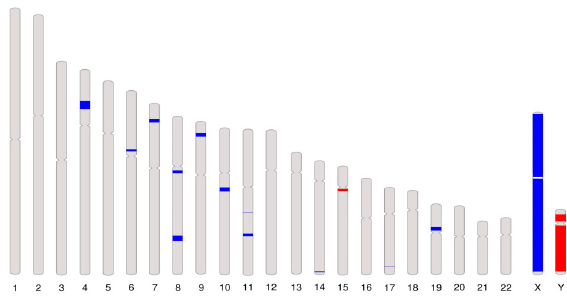
Figure 2. Representative copy number alteration (ideogram) showing gains (blue), and losses (red) in the AHOL1